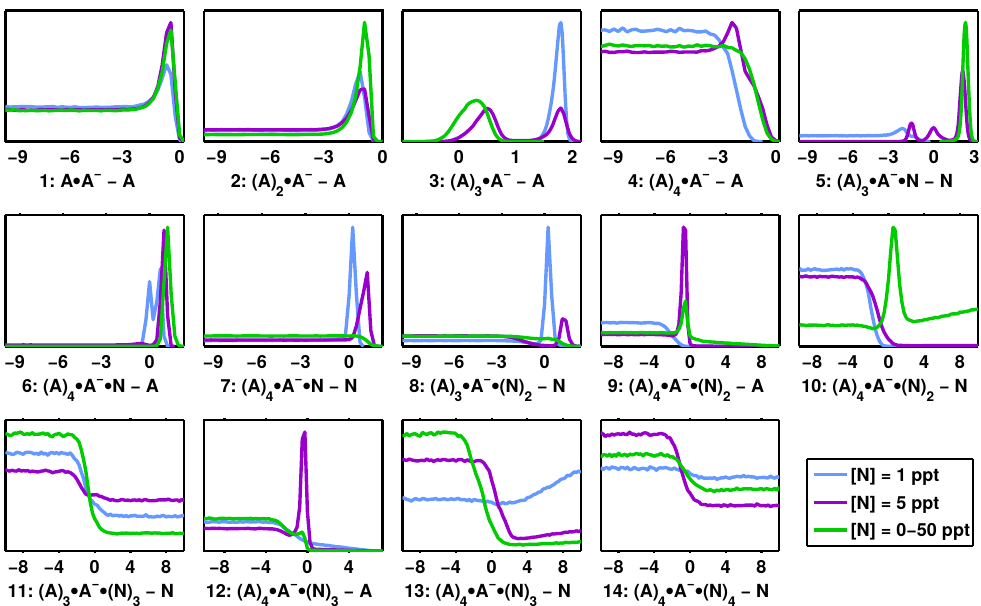
Figure 4. Posterior distributions of the base 10 logarithm of the evaporation rates (in units of s − 1 ) corresponding to the experimental cluster distributions and different options for treating the background ammonia concentration in the experiments where it was below the detection limit and therefore unknown. “A” stands for H 2 SO 4 , “A − ” for HSO − and “N” for NH 3 4